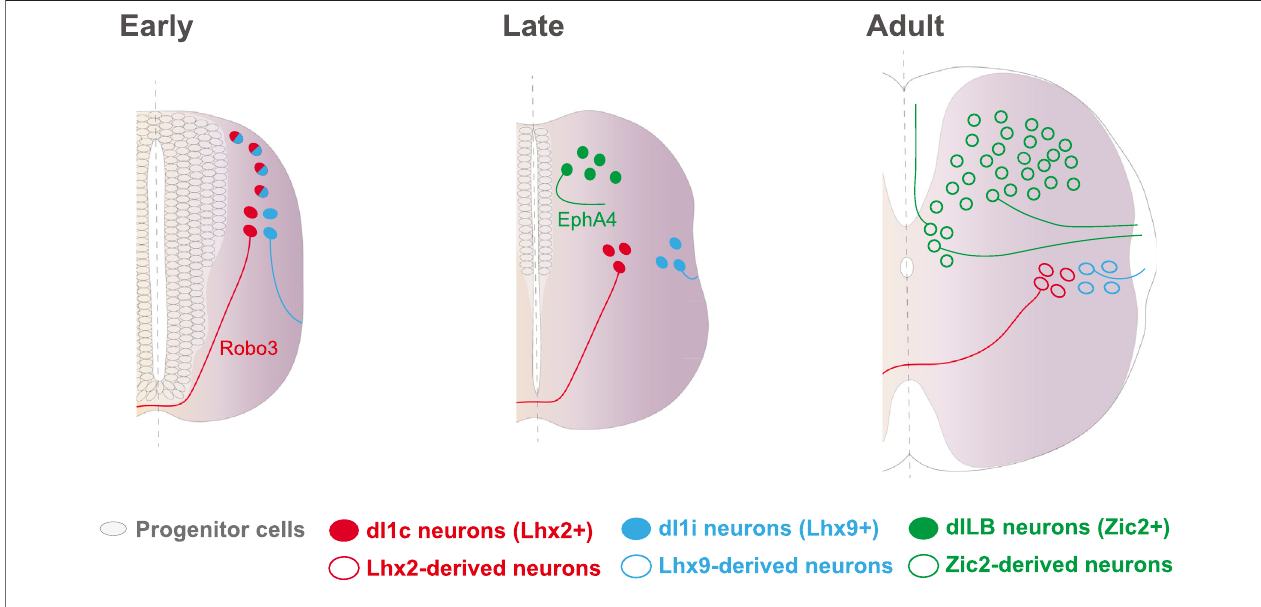
FIGURE 2 | Axon guidance strategies in different subtypes of spinal cord neurons. dI1 neurons are born early in neural tube development and are separated from the midline by the subventricular zone, populated by progenitor cells. Expression of Lhx2 in dl1 neurons activates a contralateral program, in part through the upregulation of Robo3. Ipsilateral dI1 neurons do never confront midline cues and project their axons into the ipsilateral lateral funiculus, likely through the expression ofRobo2and possibly mediated by Lhx9. Later, by thetimethat dILB neuronsare born, progenitor neurons have already differentiated and postmitotic neurons distribute at both sides of the dorsal midline. In this scenario, EphA4 and likely other guidance molecules, are controlled by Zic2 to ensure midline repulsion and ipsilateral projection through the dorsal and lateral funiculi. These TFs are downregulated following development and are not expressed in adulthood.